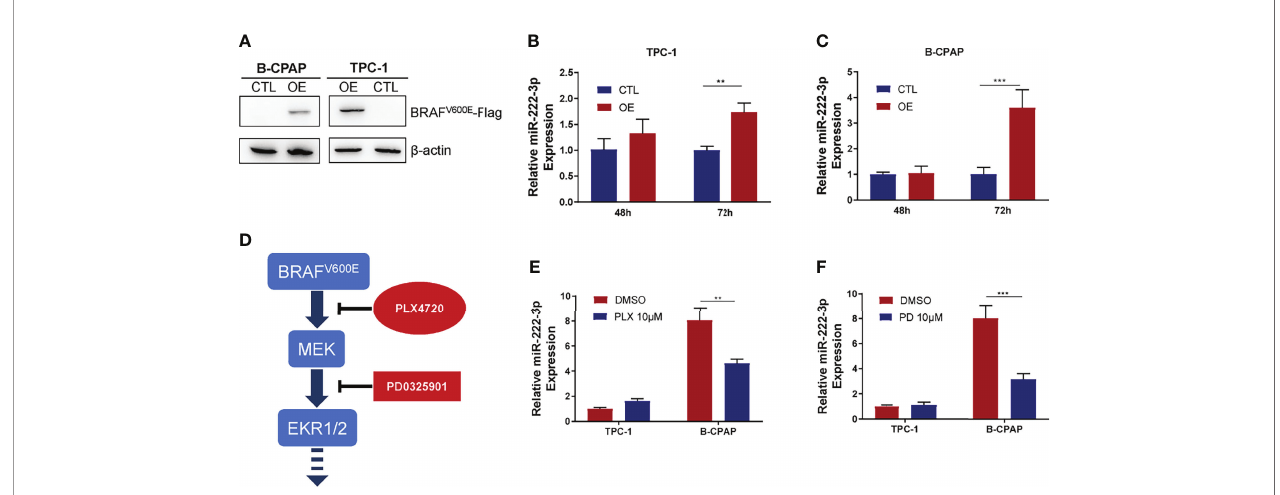
FIGURE 2 | BRAF V600E oncoprotein regulates miR-222-3p expression in PTCs. (A) immunoblot of BRAF V600E -Flag protein from extracts of TPC-1 and B-CPAP transfected with OE plasmid or empty vector. (B, C) q-PCR validation of expression level of miR-222-3p in TPC-1 and B-CPAP transfected with OE plasmid or empty vector after 48 h and 72 h. Bars represent means ± SD of 3 independent experiments each measured in triplicate. **p < 0.01; ***p < 0.001. (D) Model of inhibitors suppresses BRAF V600E - MEK-ERK pathway. (E) q-PCR validation of expression level of miR-222-3p in B-CPAP and TPC-1 treated with 10 m M PLX4720 or DMSO after 24 h. Bars represent means ± SD of 3 independent experiments each measured in triplicate. **p < 0.01. (F) q-PCR validation of expression level of miR-222-3p in B-CPAP and TPC-1 treated with 10 m M PD0325901 or DMSO after 24 h. Bars represent means ± SD of 3 independent experiments each measured in triplicate. ***p <